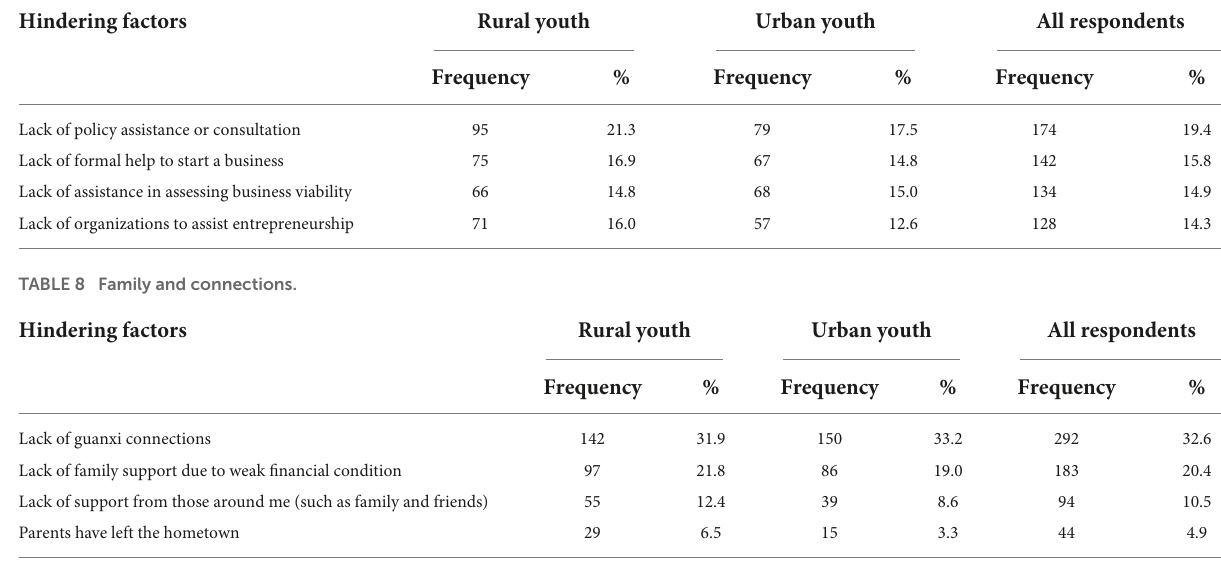
TABLE 7 Startup incubation.